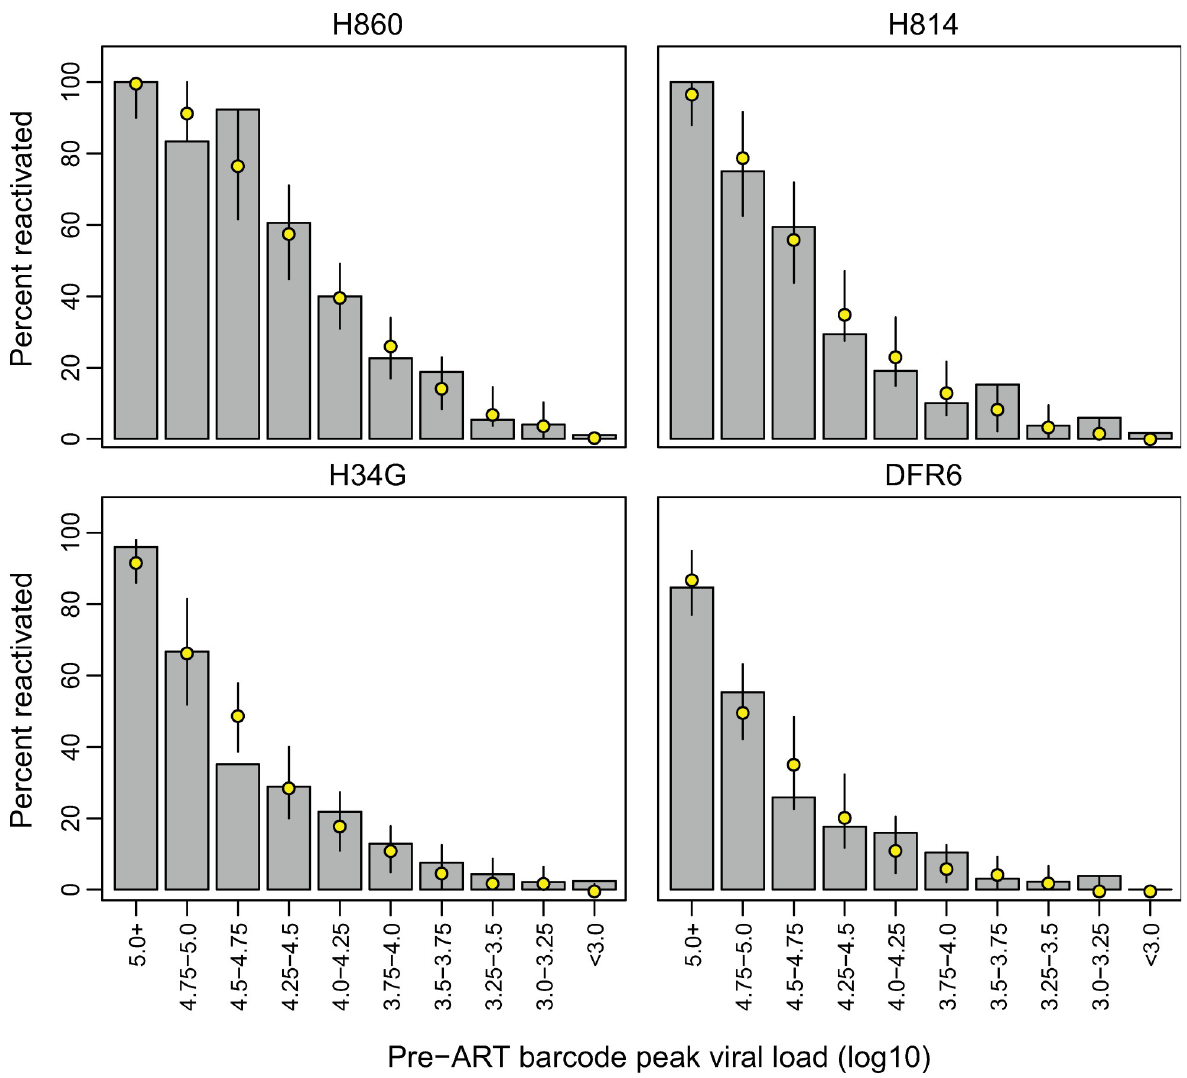
Fig 4. Size of viral lineage pre-ART predicts reactivation after treatment discontinuation. Barcodes were partitioned into 0.25-log 10 intervals based on their pre-ART plasma viral loads. The grey bars depict the proportion of barcodes from each viral load category that were observed at peak rebound viremia during ATI-2. The yellow points correspond to the median simulated number of reactivated barcodes in each category, with 90% credibility intervals.